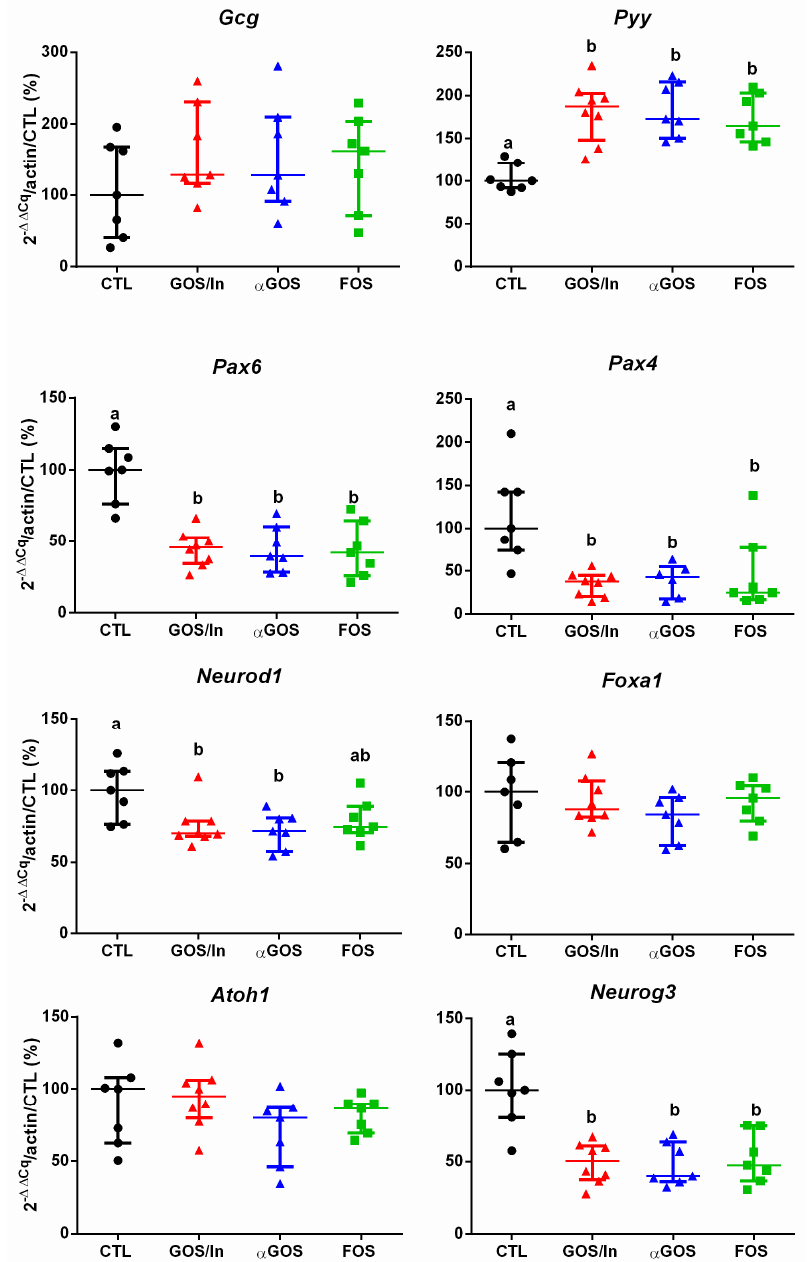
Figure 3. Relative expression of genes implied in the endocrine lineage and in L-cells di ff erentiation in the ileum. Di ff erent letters indicate significant di ff erence between groups ( p < 0.05). Data are fold-change expressed in % of CTL group. Individual values, median with interquartile range are plotted ( n = 7 to 8 per group).